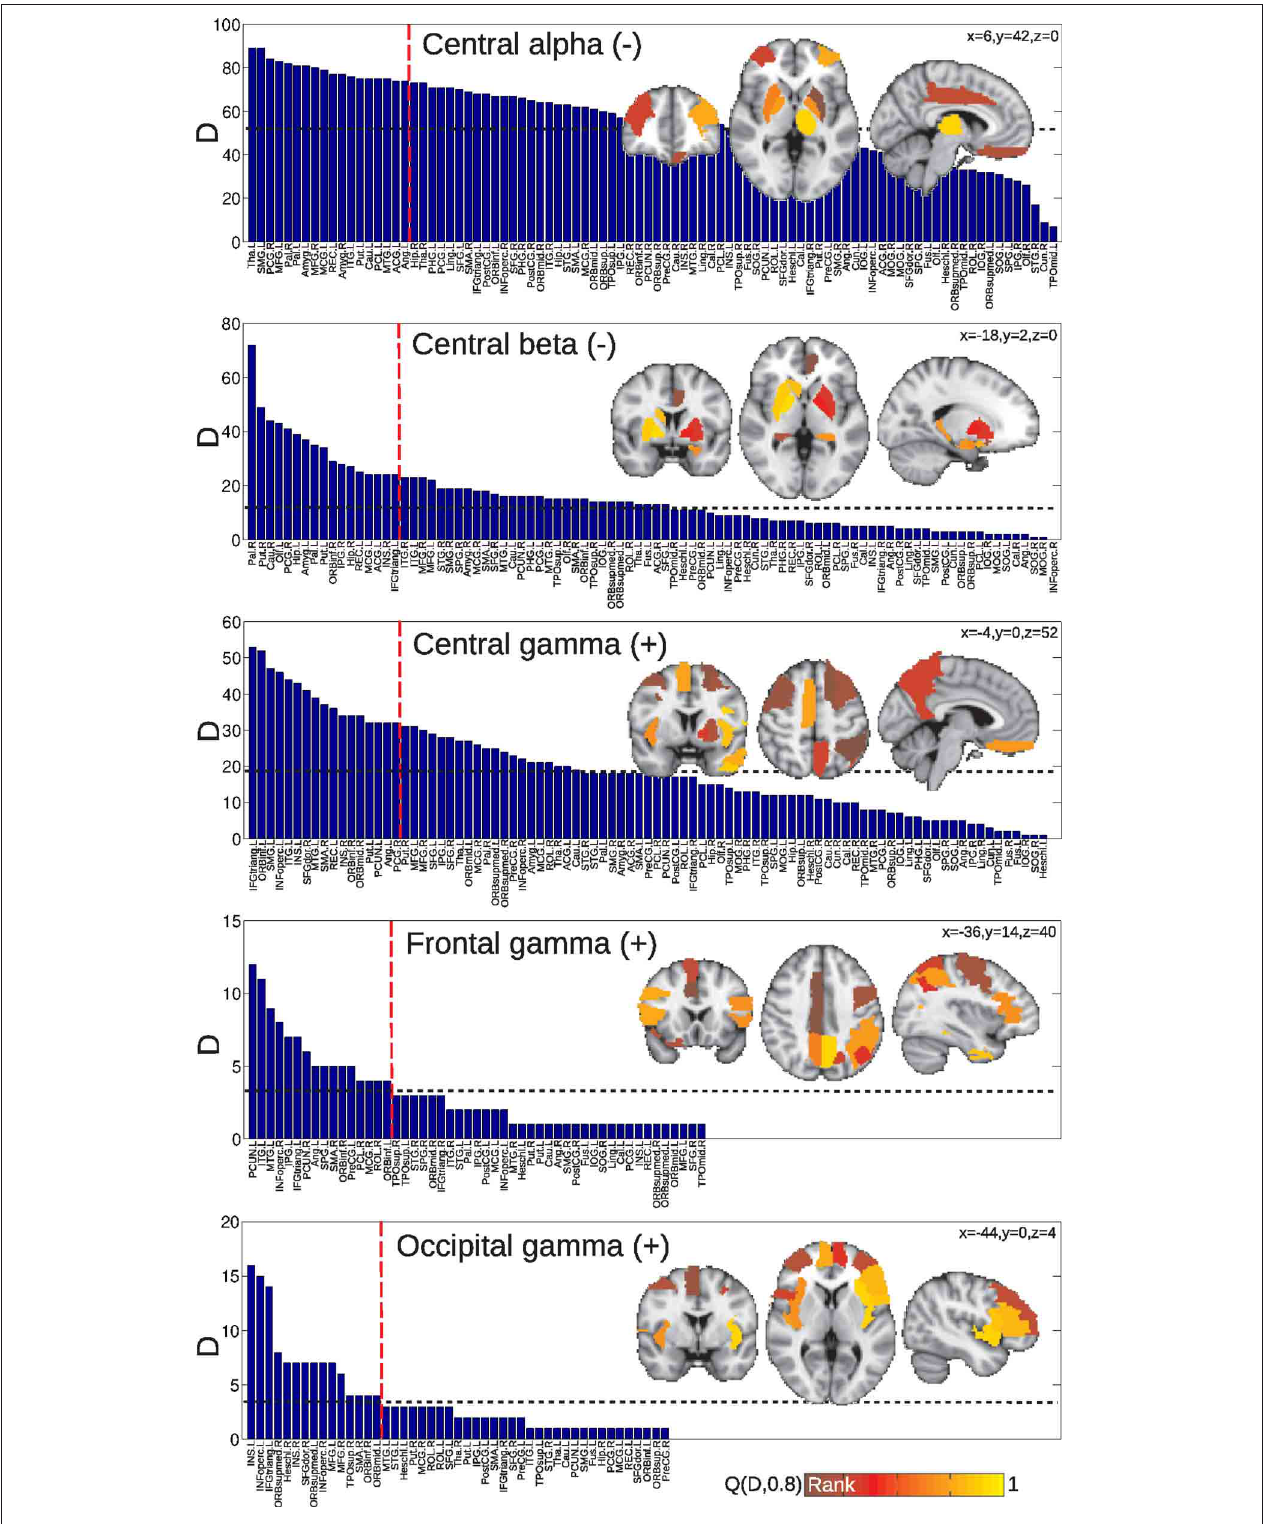
FIGURE 6 | Anatomical regions (or nodes) ranked according to the numberof connectionsattachedto themwhichcorrelatewithEEGpower fluctuations in different frequencies. In the inset, the regions corresponding